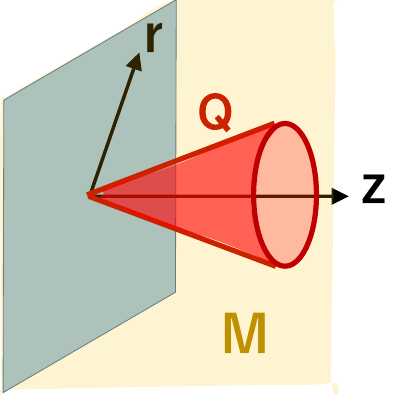
Figure 13 . A sketch of a solution of AdS 3 / BCFT 2 with a conical EOW brane. Note the gravity dual is the region outside of the